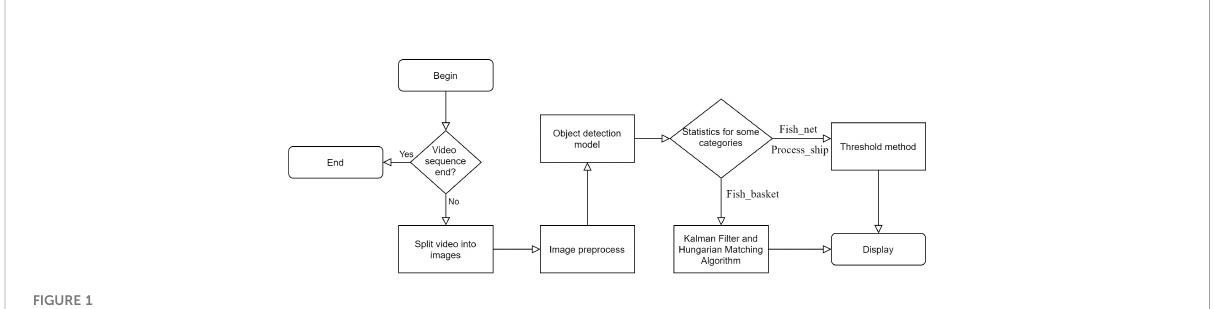
FIGURE 1 Overall fl ow chart of the proposed